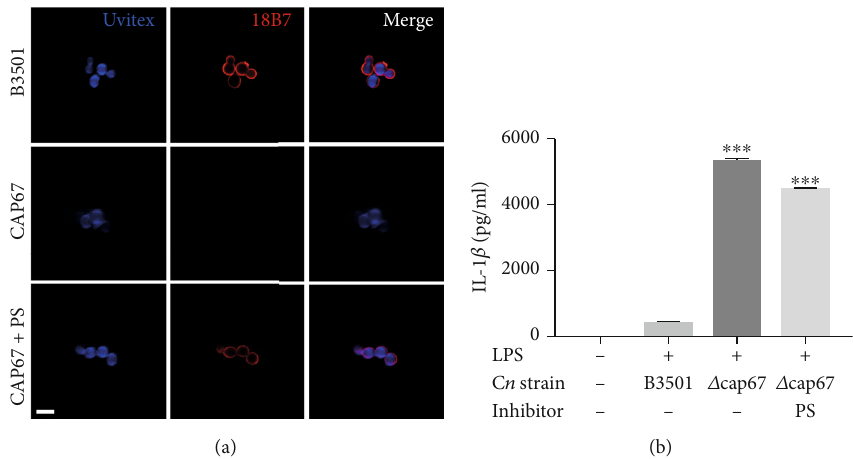
Figure 1: Exopolysaccharide incorporation on an acapsular mutant does not impair macrophage in fl ammasome activation. (a) GXM detection by immuno fl uorescence of B3501, CAP67 ( Δ cap67 ), and CAP67+PS ( Δ cap67 coated with polysaccharides from B3501) labeled with Uvitex2B (blue) and mAb against GXM (18B7) (red). (b) BMDMs were stimulated with LPS (500ng/ml) and infected with opsonized B3501, Δ cap67 , or Δ cap67 +PS strains (MOI 2 :1) for 24 h. Statistical analysis was performed using one-way ANOVA, where ∗∗∗ P ≤ 0 : 001 . Comparisons were made with the B3501-infected